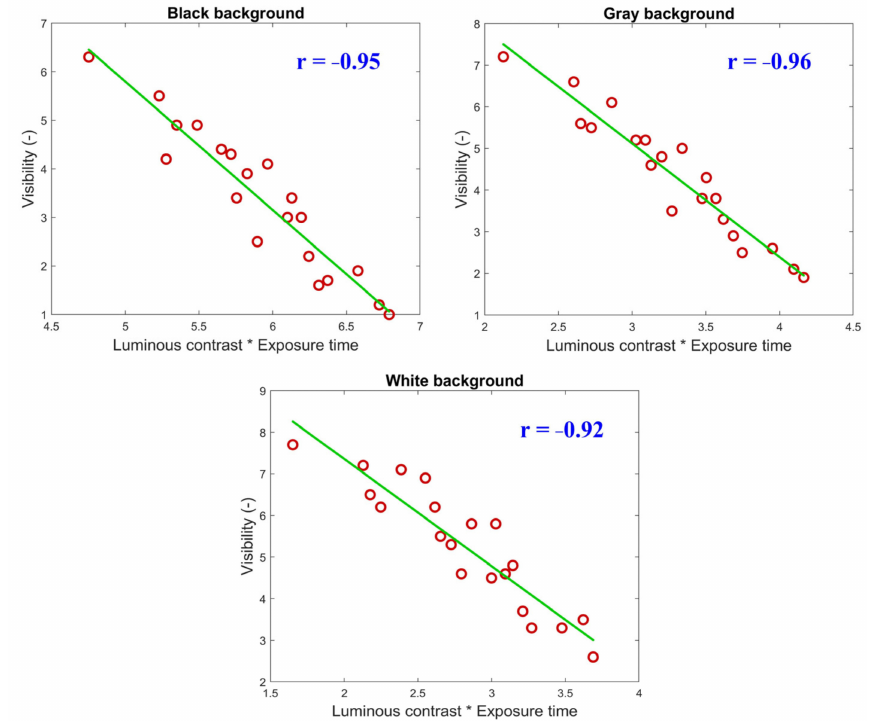
Figure 11. Relationship between visibility and luminance contrast with exposure time (Stimu-